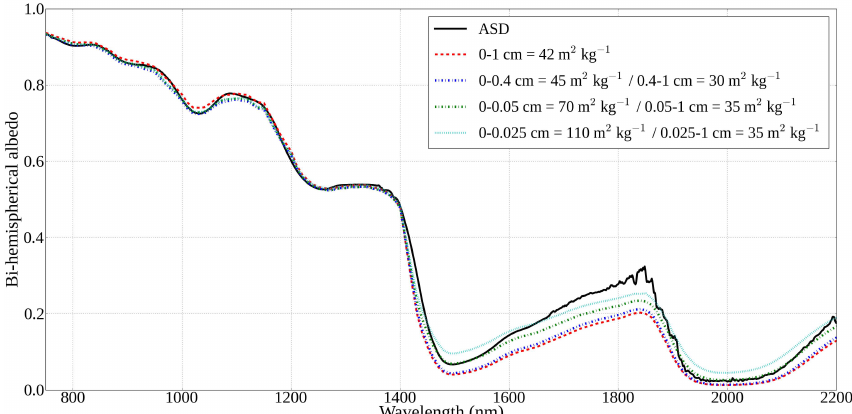
Fig. 11. Impact of the surface layer properties on the simulated albedo at Summit, on 15 June 2011. The black solid line represents the measured albedo and the red dashed line the simulation with experimental data, using in particular the SSA value measured in the first cm of snow. All the other curves correspond to simulations in which the first cm was split into two sub-layers and different combinations of thickness and SSA (reported in the legend) were tested: the blue and green dashed-dotted lines represent attempts to match the observed values and the cyan dotted line is the simulation with values from Grenfell et al.